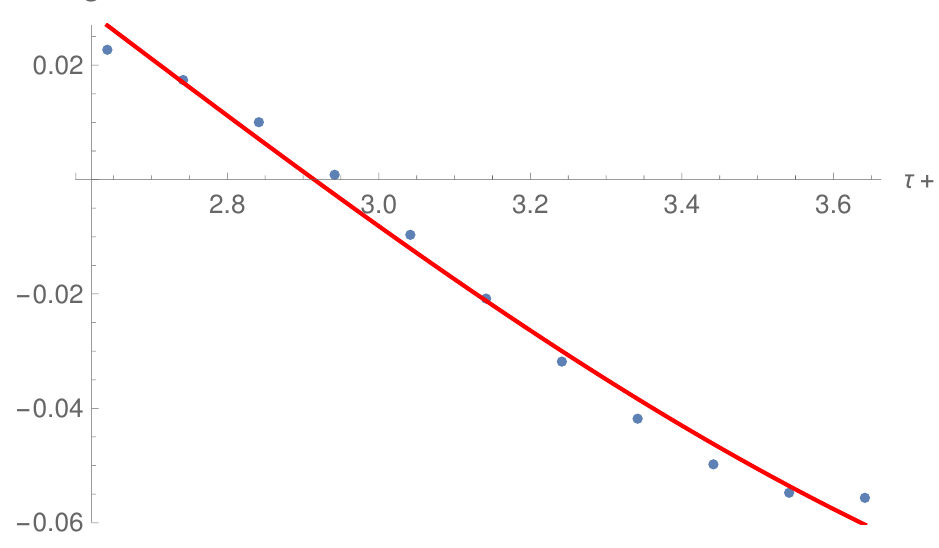
Figure 5: Cosine fit to the data with step-size = 0.05. λ